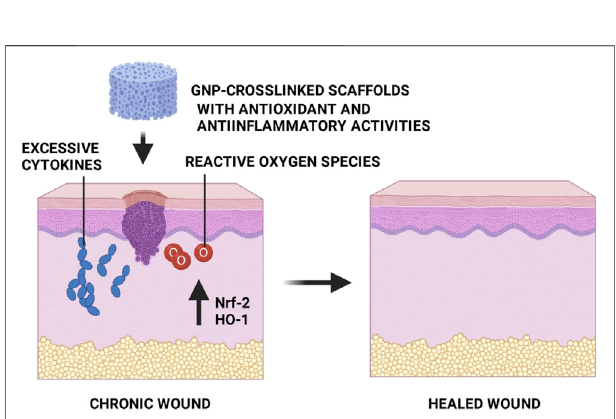
FIGURE 8 | Effects of GNP in cytokine secretion. GNP decreased the production of cytokines which represented its antiin fl ammatory activity. This fi gure is reproduced from Szymanski et al.